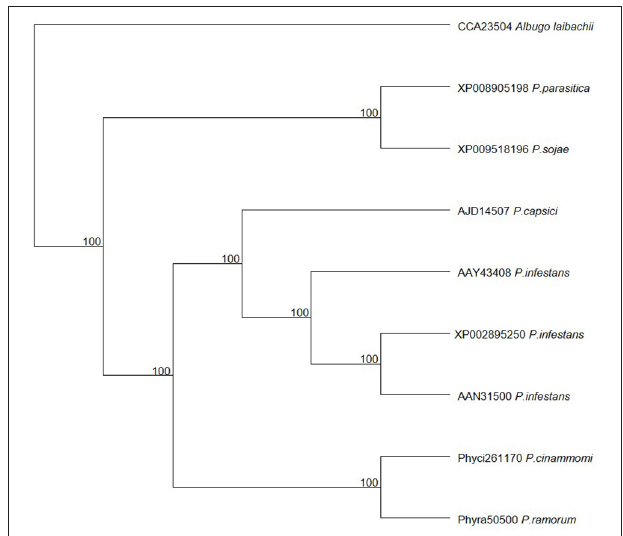
FIGURE 2 | Maximum likelihood phylogenetic tree of the putative Phytophthora cinnamomi crinkler (CRN) protein in relation to CRN proteins in other Phytophthora species.